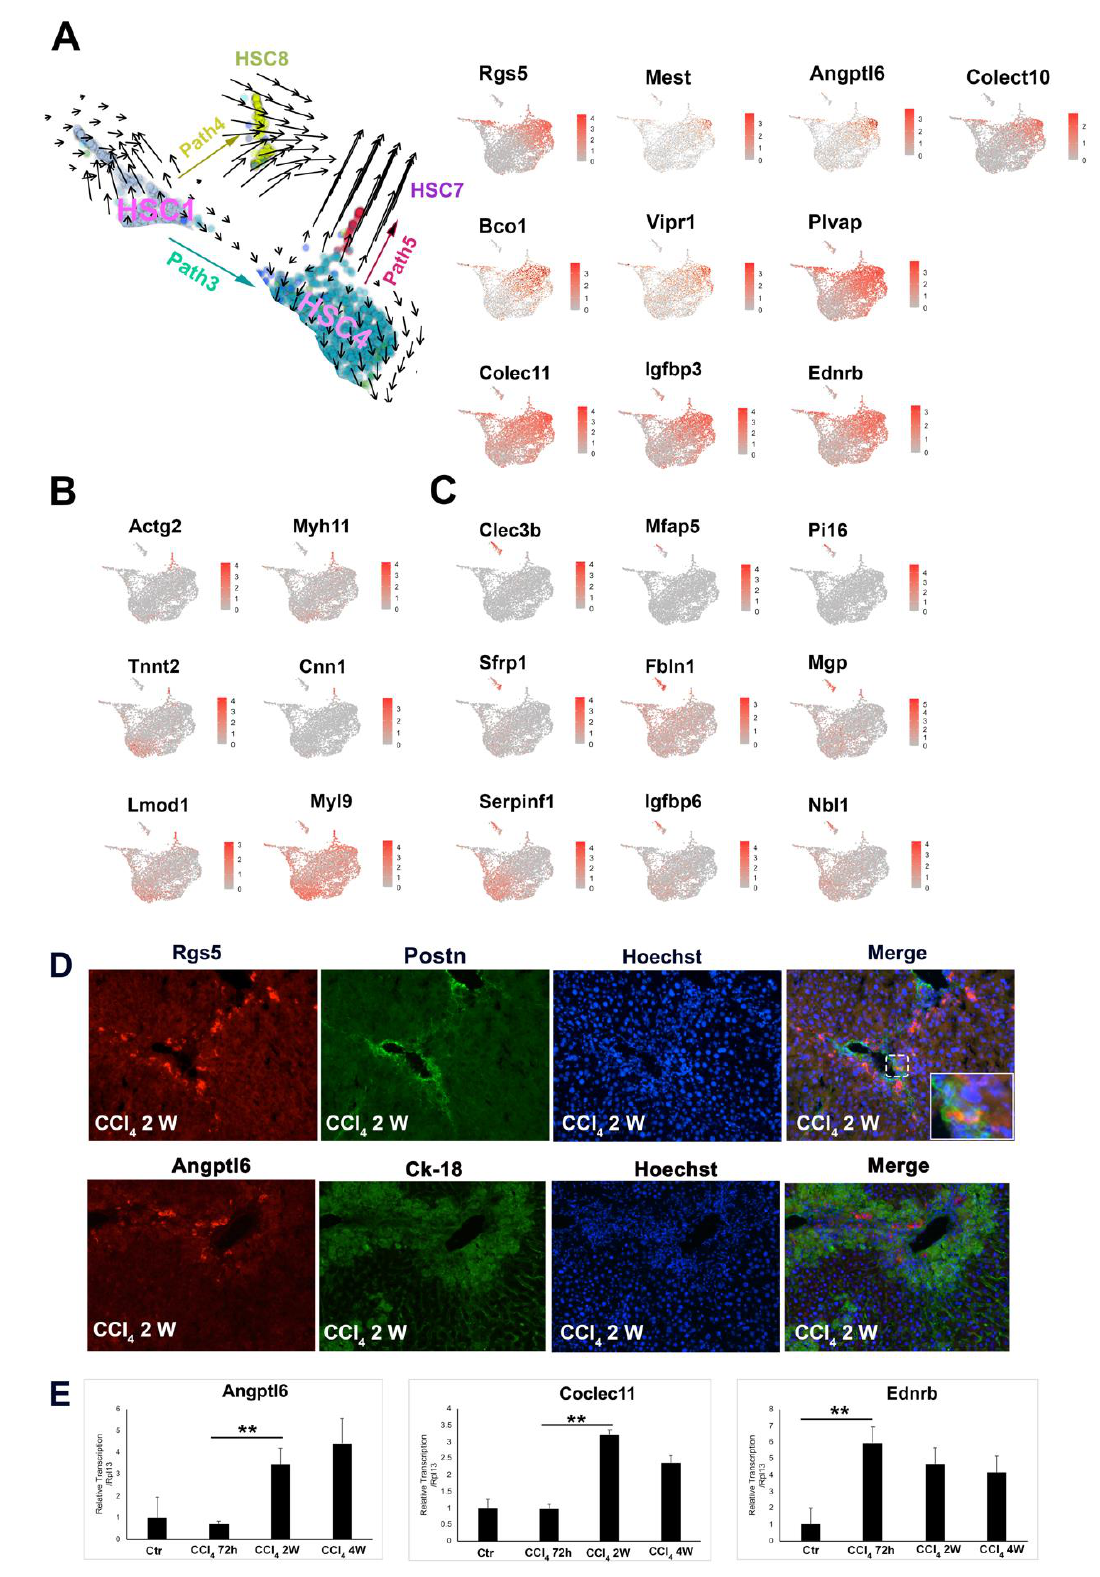
Figure 5. HSC4, HSC7, and HSC8 as novel HSC subtypes in CCl 4 -treated mouse liver. ( A ) Left panel, scRNA velocity analysis overlaid on UMAP plot suggested the trajectory path from HSC1 to HSC4 and HSC8, and HSC4 to HSC7 indicated